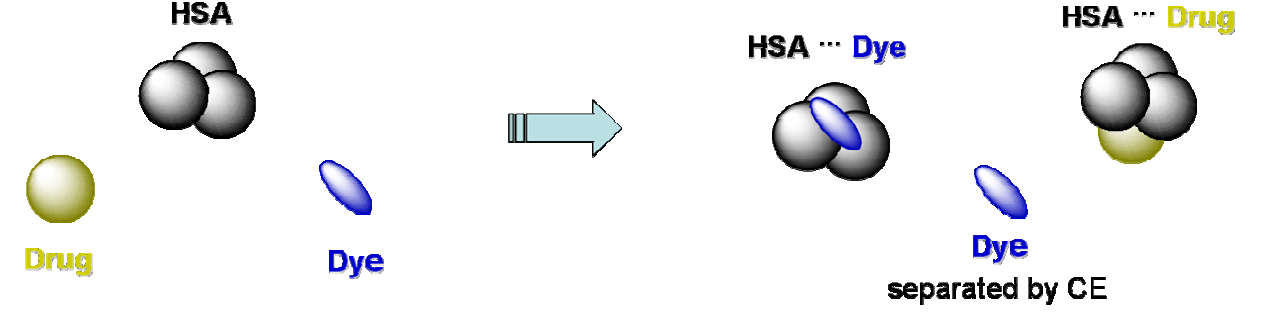
Figure 3. Illustration of competitive binding of the drug and dye with